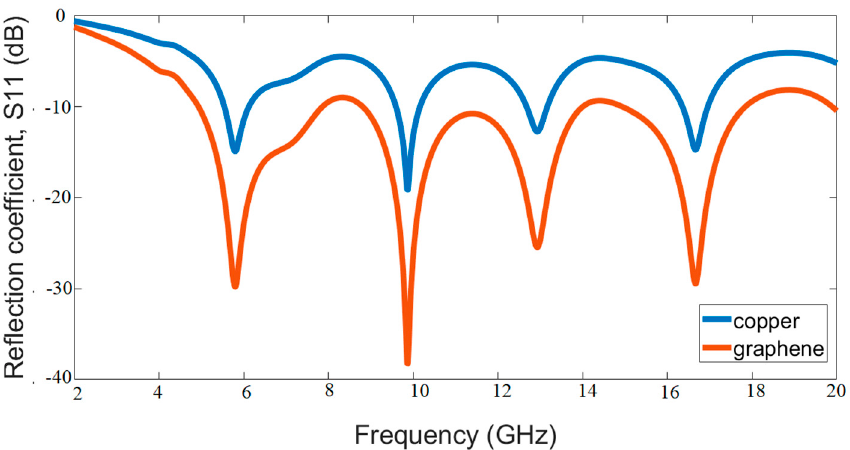
Figure 12. The simulation comparison results of the return loss (S 11 ) of the graphene-based antenna and copper-based antenna for Antenna-1 in this study.